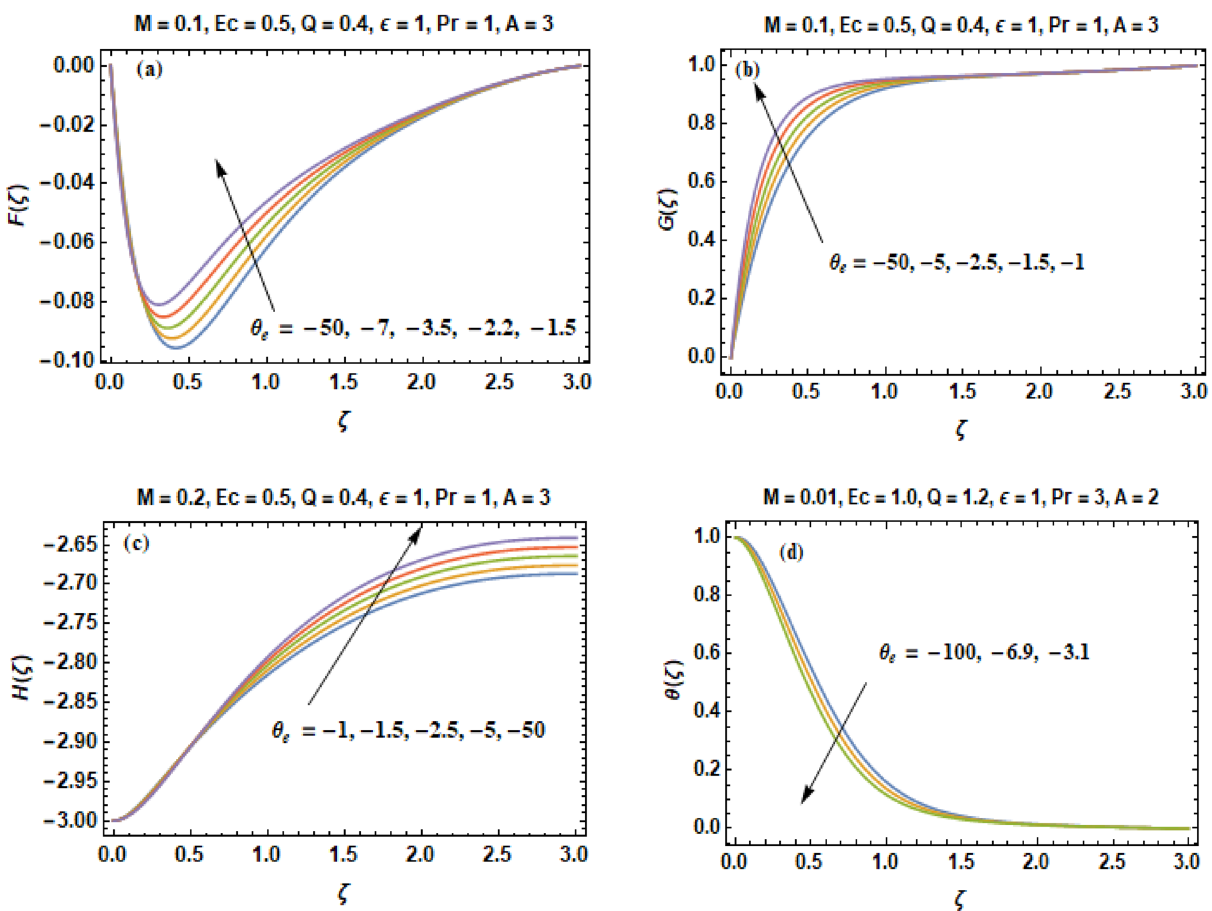
Figure 6. ( a–d ) Components of velocity (F, G, H) & temperature profile (θ) versus variable viscosity parameter θ e < 0.